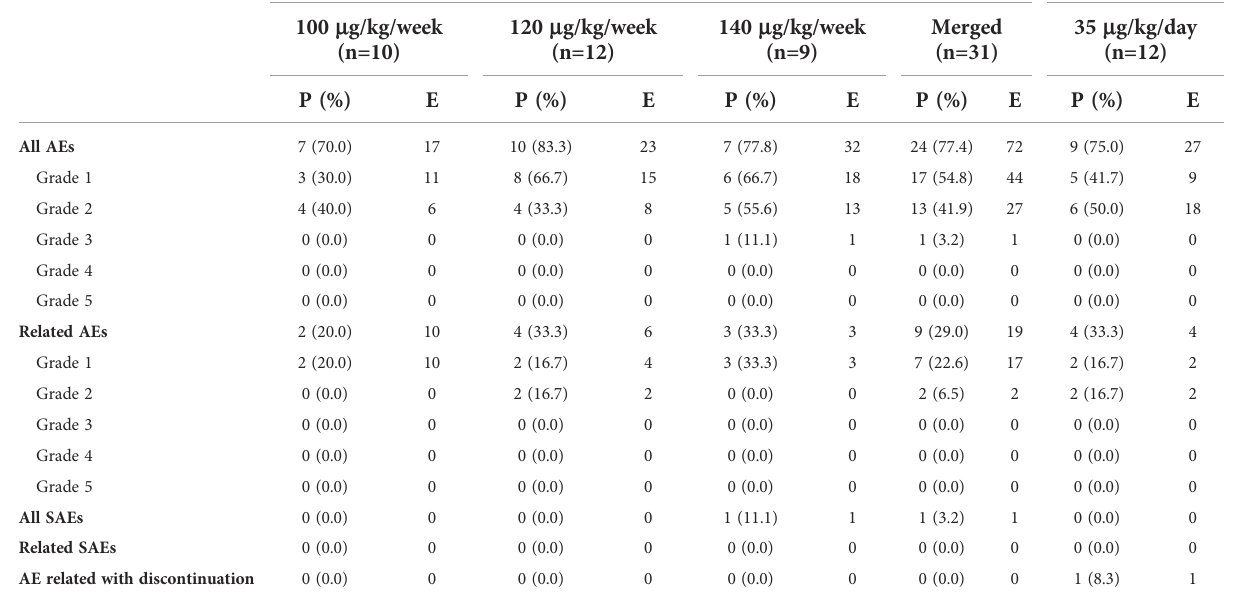
TABLE 6 Adverse events in safety analysis